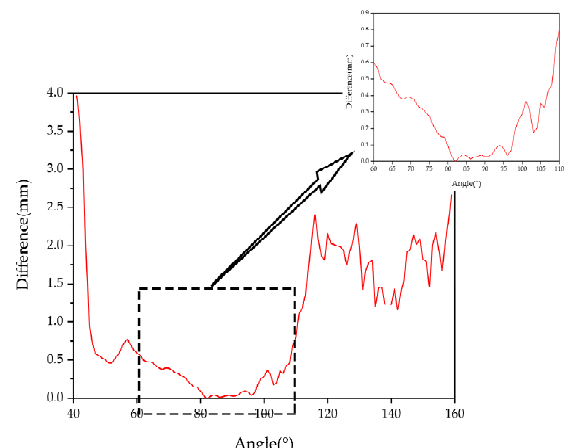
Figure 5. Pitch angle measurement results.